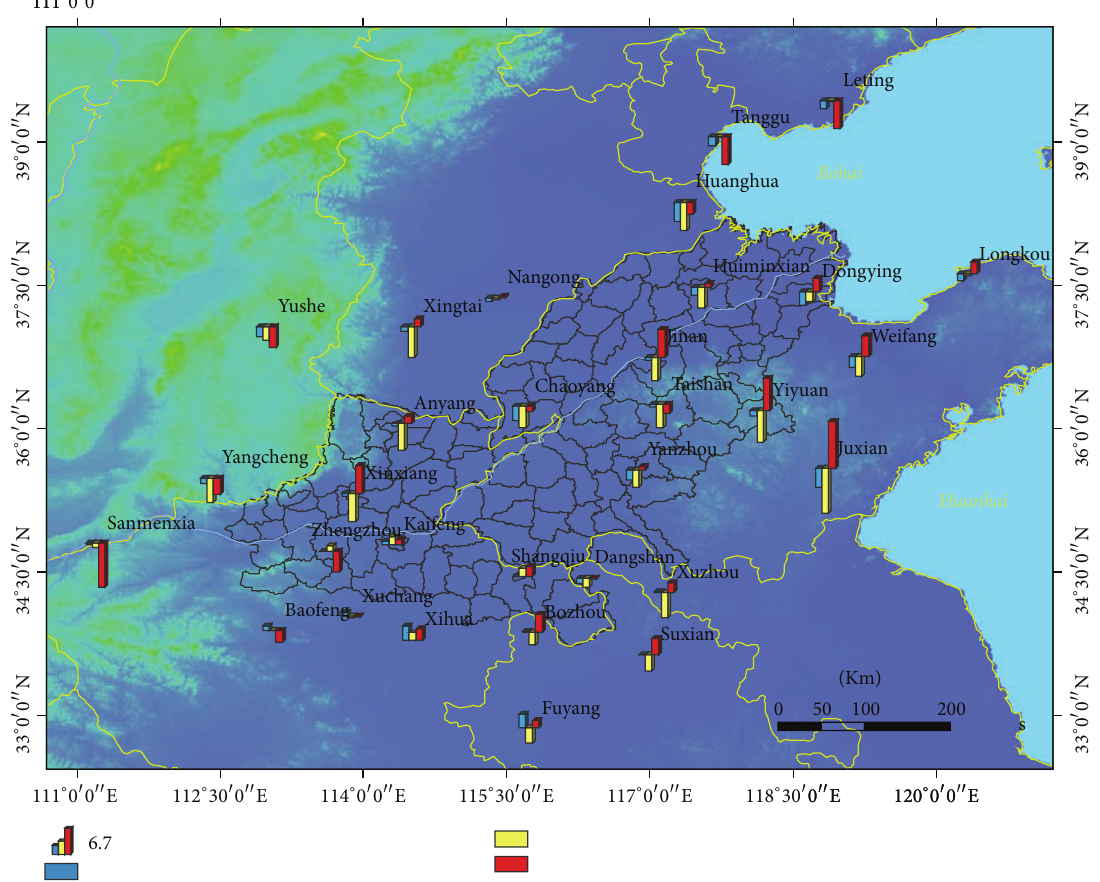
Figure 10: Average annual precipitation trend rates at stations in the Lower Yellow River Region from 1960 to 2001(unit of measurement